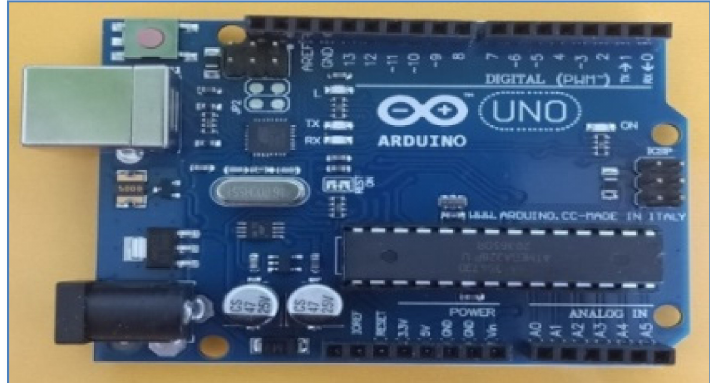
Figure 10. Arduino UNO implementation